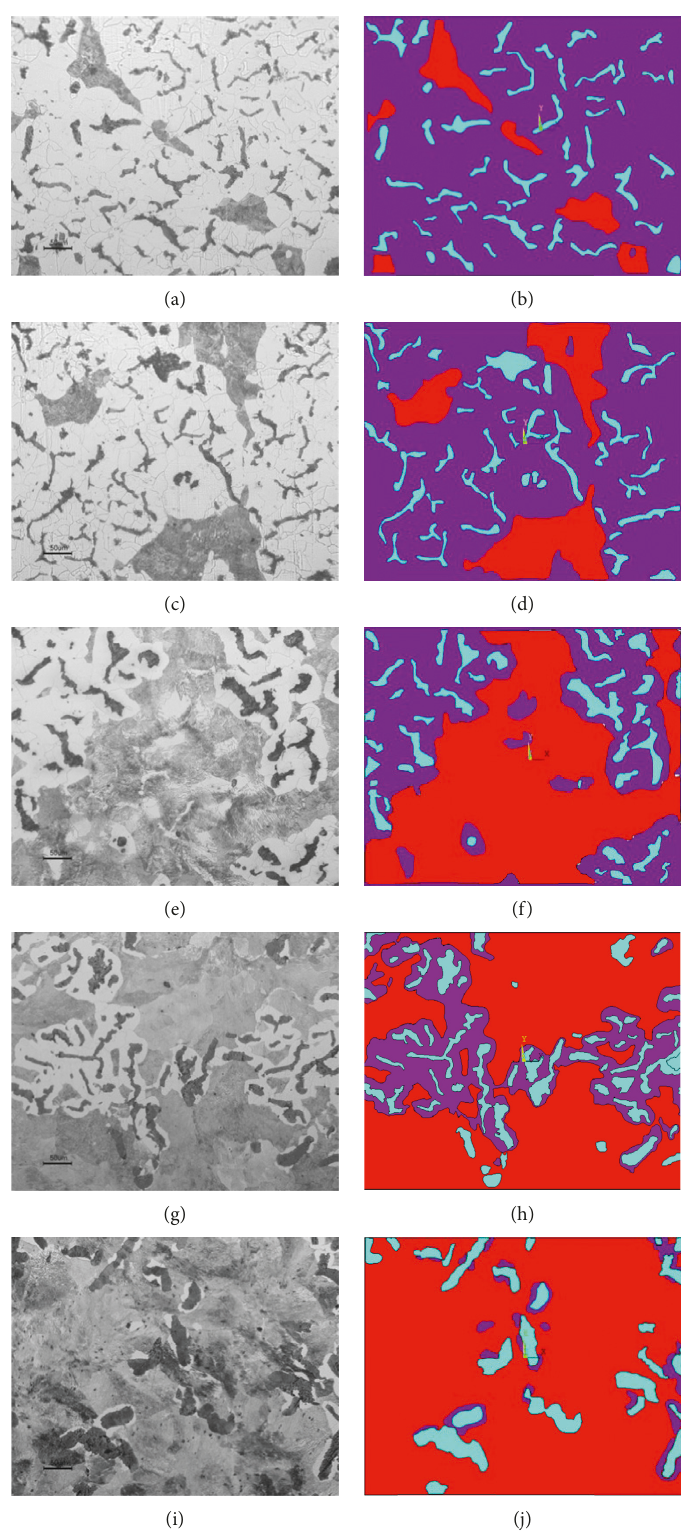
Figure 3: Microstructure of CGI and corresponding FE model with different pearlite contents. Microstructure: (a) 10%; (c) 20%; (e) 40%; (g) 60%; (i) 80%; FE models: (b) 10%, (d) 20%, (f) 40%, (h) 60%, (j)